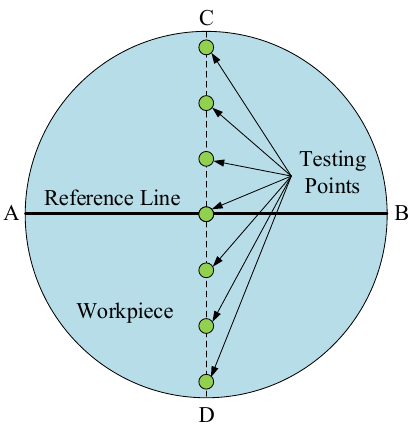
Figure 8. The schematic diagram of selected testing positions.